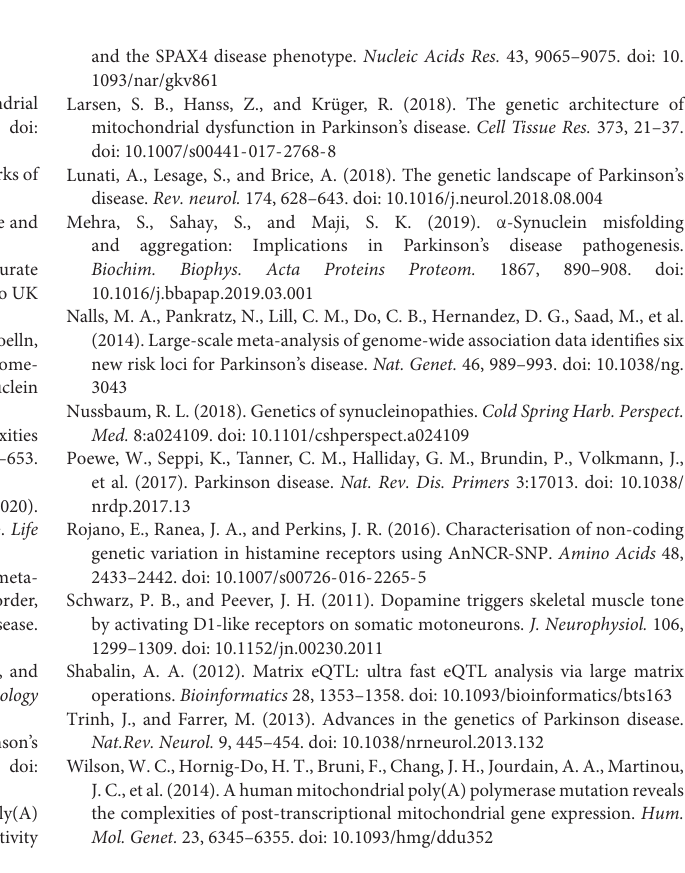
Supplementary Figure 1 | (A) The Manhattan diagram of GUB GWAS data. (B) The Manhattan diagram of GIPD GWAS data. Supplementary Figure 2 | (A) The Manhattan diagram of Brain eQTL data. (B) The Manhattan diagram of Cage eQTL data. (C) The Manhattan diagram of CD4 eQTL data. (D) The Manhattan diagram of CD8 eQTL data. Supplementary Figure 3 | (A) The Summary data-based Mendelian Randomization (SMR) analysis results of GUB_Brain. (B) The SMR analysis results of GIPD_Brain. (C) The SMR analysis results of GUB_Cage. (D) The SMR analysis results of GIPD_Cage. (E) The SMR analysis results of GUB_CD4. (F) The SMR analysis results of GIPD_CD4. (G) The SMR analysis results of GUB_CD8. (H) The SMR analysis results of